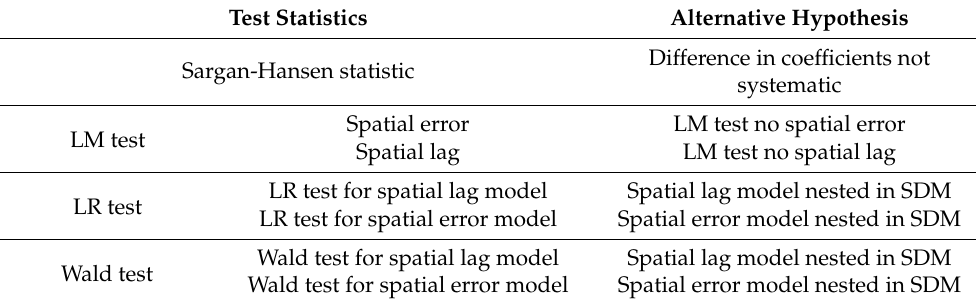
Table 4. Hypotheses associated with post hoc